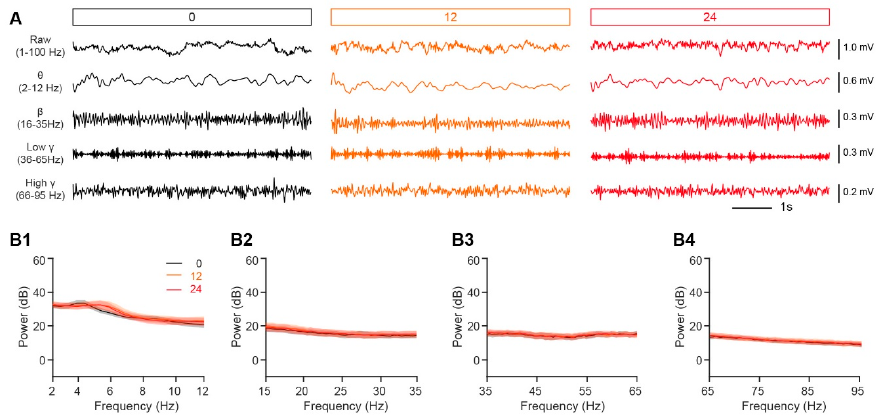
Figure 4. Nutritional status has no significant effect on the ongoing LFP in the OB. ( A ) Examples of ongoing baseline LFP signals from a single mouse fasted for 0 h (black), 12 h (orange), and 24 h (red). The first row shows 6 s of the raw trace; the second to fifth rows show the filtered signal (theta, beta, low gamma, and high gamma, respectively). ( B ) The averaged power spectrum of the ongoing LFP signals. B1–B4 show the averaged power spectrum in the theta ( B1 ), beta ( B2 ), low gamma ( B3 ), and high gamma ( B4 ) bands across the group of mice. B1. Friedman’s test: χ 2 (2,38) = 0.57, P = 0.75. B2. Friedman’s test: χ 2 (2, 80) = 2.06, P = 0.36. B3. Friedman’s test: χ 2 (2, 118) = 2.85, P = 0.24. B4. One-way rANOVA: F (2,116) = 1.09, P = 0.34. Error bars show the SEM.